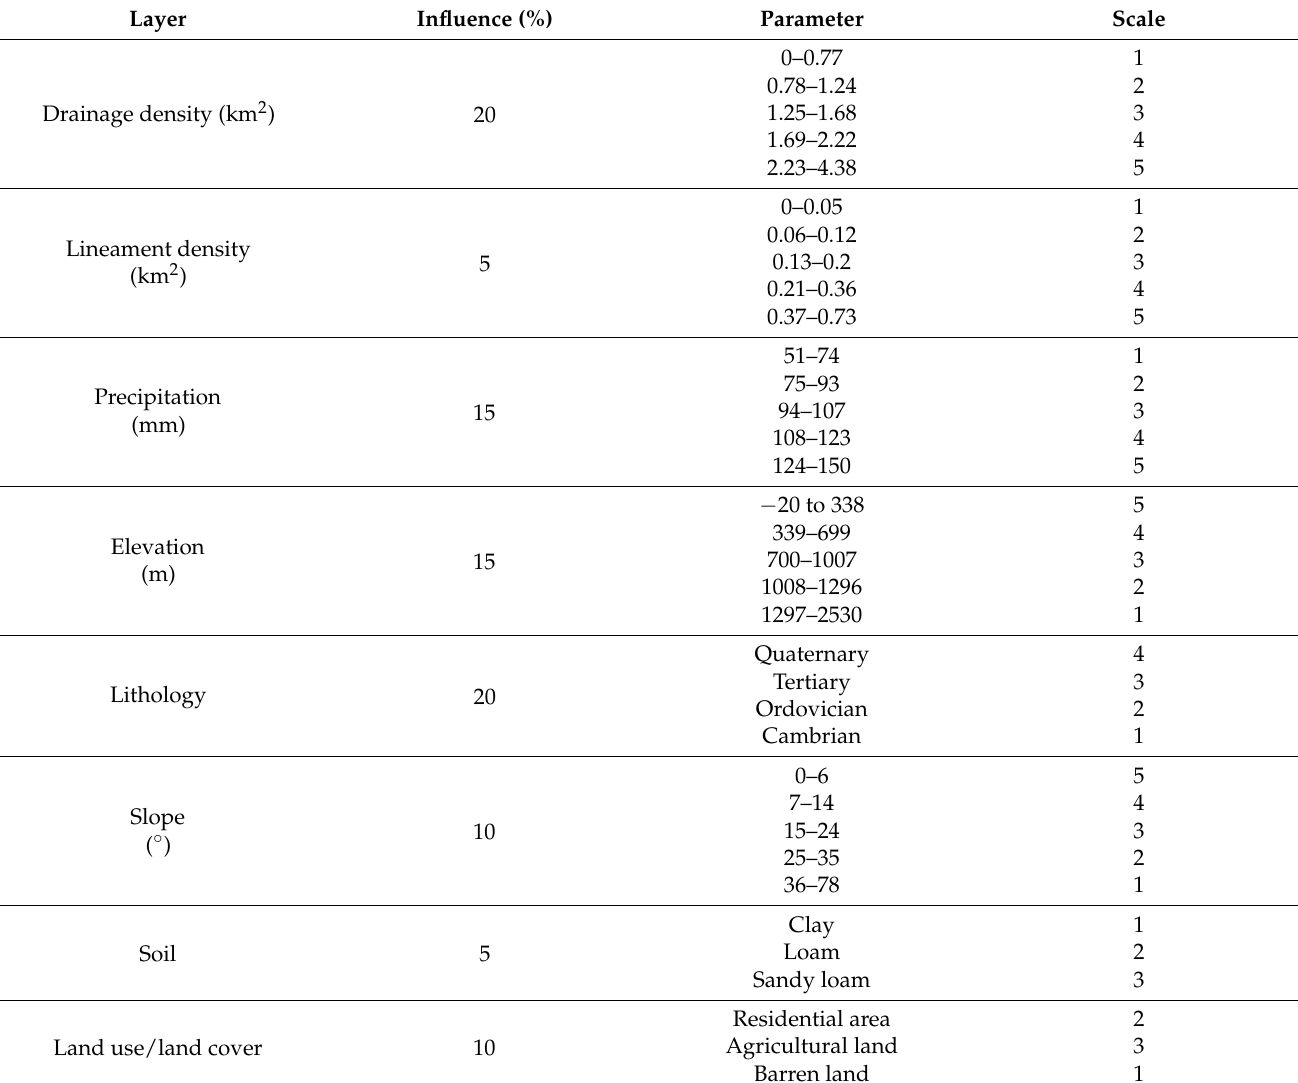
Table 1. Showing the eight layers used in the overlay analysis to find potential groundwater zones and their influences, classes, and